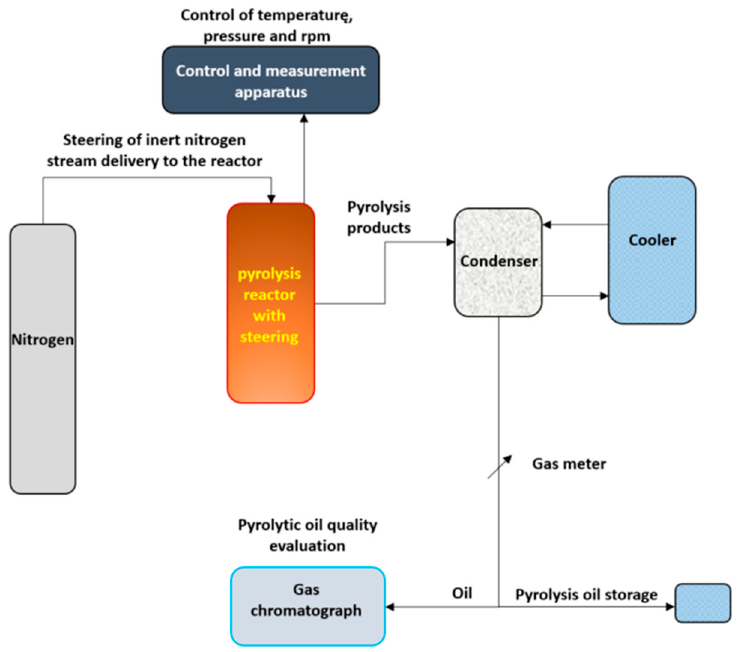
Figure 7. Schematic diagram of an exemplary pyrolysis reactor according to the concept of [84], with permission from Elsevier.